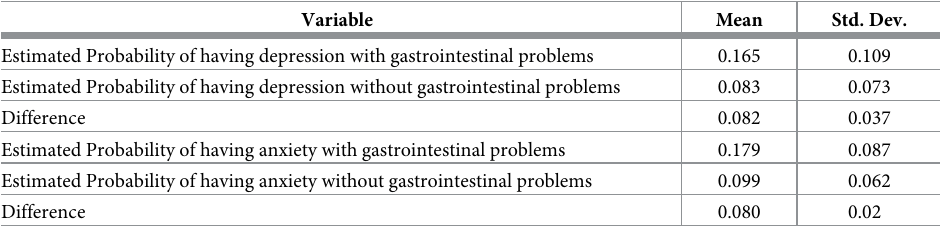
Table 5. Predicted probabilities. Variable Mean Std. Dev. Estimated Probability of having depression with gastrointestinal problems 0.165 0.109 Estimated Probability of having depression without gastrointestinal